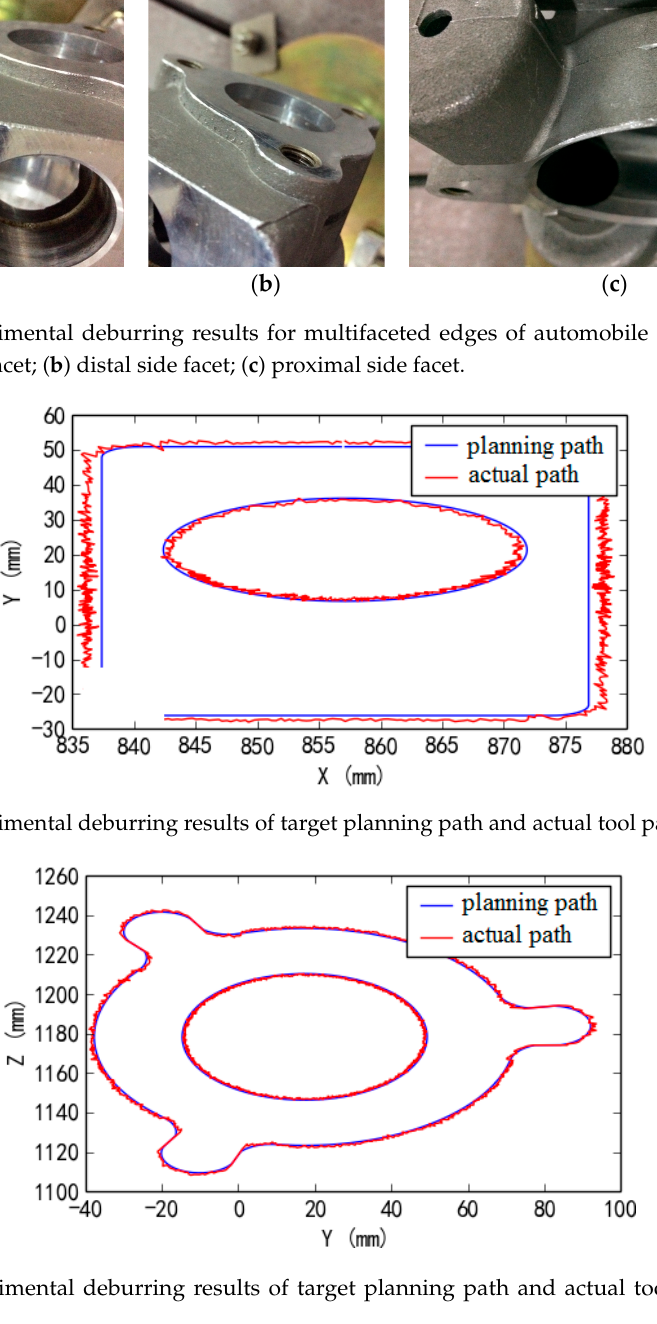
Figure 30. Experimental deburring results of target planning path and actual tool path of distal side facet.